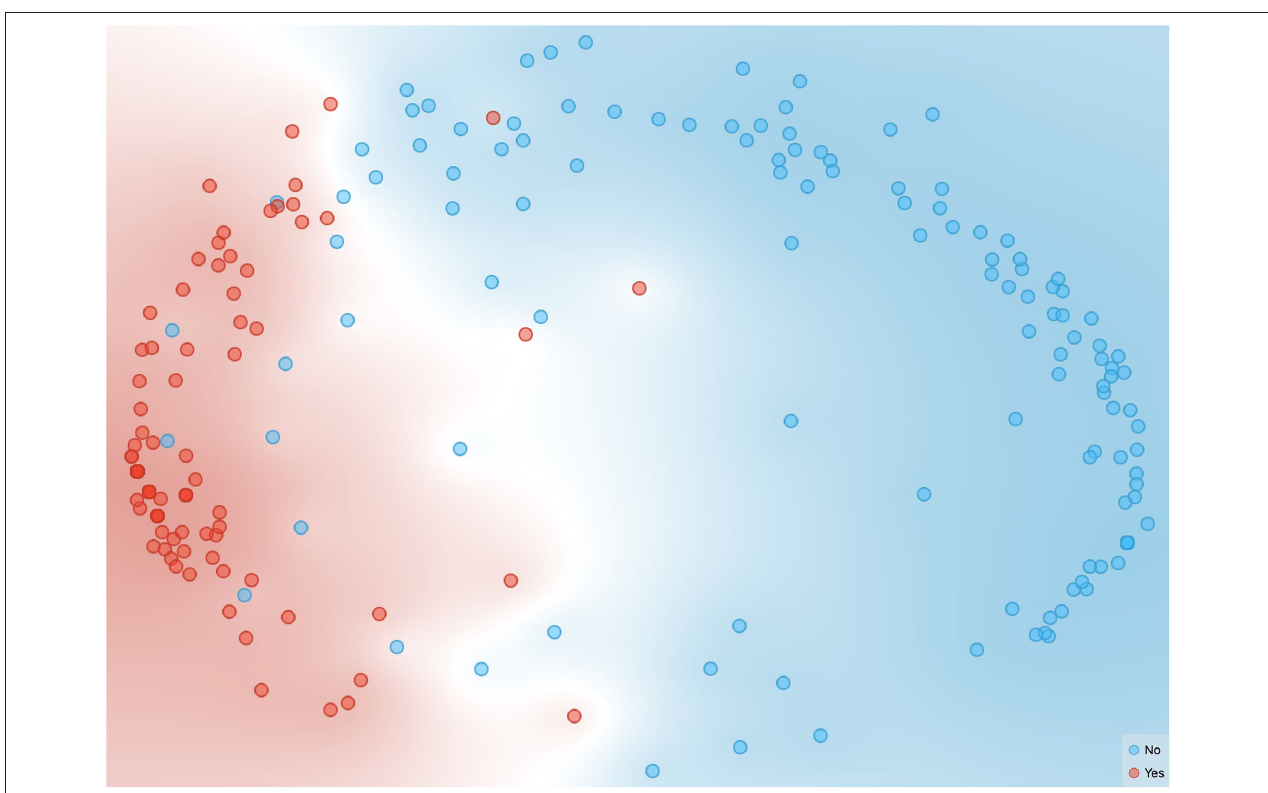
FIGURE 2 | Multidimensional scaling (MDS) visualization of the students. In red, we show the students who complete the course, and blue represents the ones that dropped out.